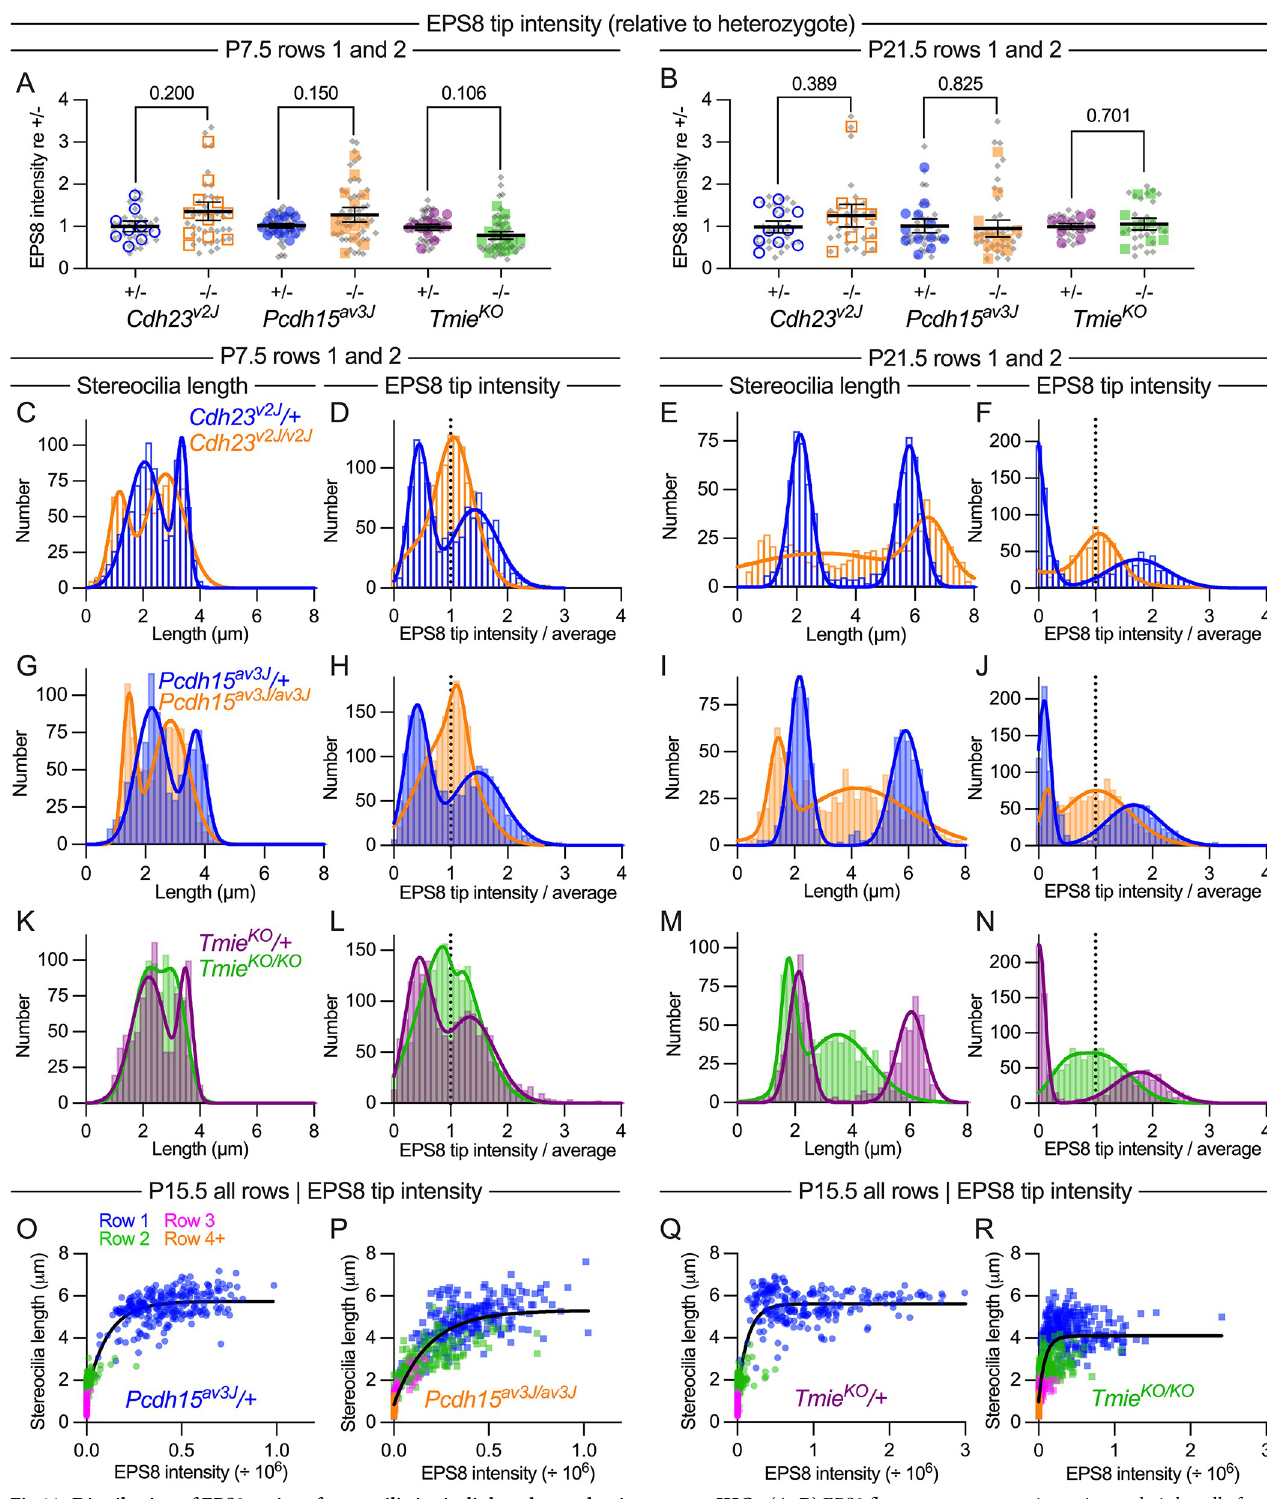
Fig 11. Distribution of EPS8 at tips of stereocilia in tip-link and transduction mutant IHCs. ( A, B ) EPS8 fluorescence average intensity per hair bundle for all measured stereocilia (rows 1 and 2) for Cdh23 v2J , Pcdh15 av3J , and Tmie KO hair cells at P7.5 (A) and P21.5 (B). Plotting and statistical testing were as in Fig 3. ( C–F ) Frequency distribution of stereocilia length and EPS8 tip intensity in Cdh23 v2J hair cells. ( G–J ) Frequency distribution of stereocilia length and EPS8 tip intensity in Pcdh15 av3J hair cells. (K–N ) Frequency distribution of stereocilia length and EPS8 tip intensity in Tmie KO hair cells. Stereocilia